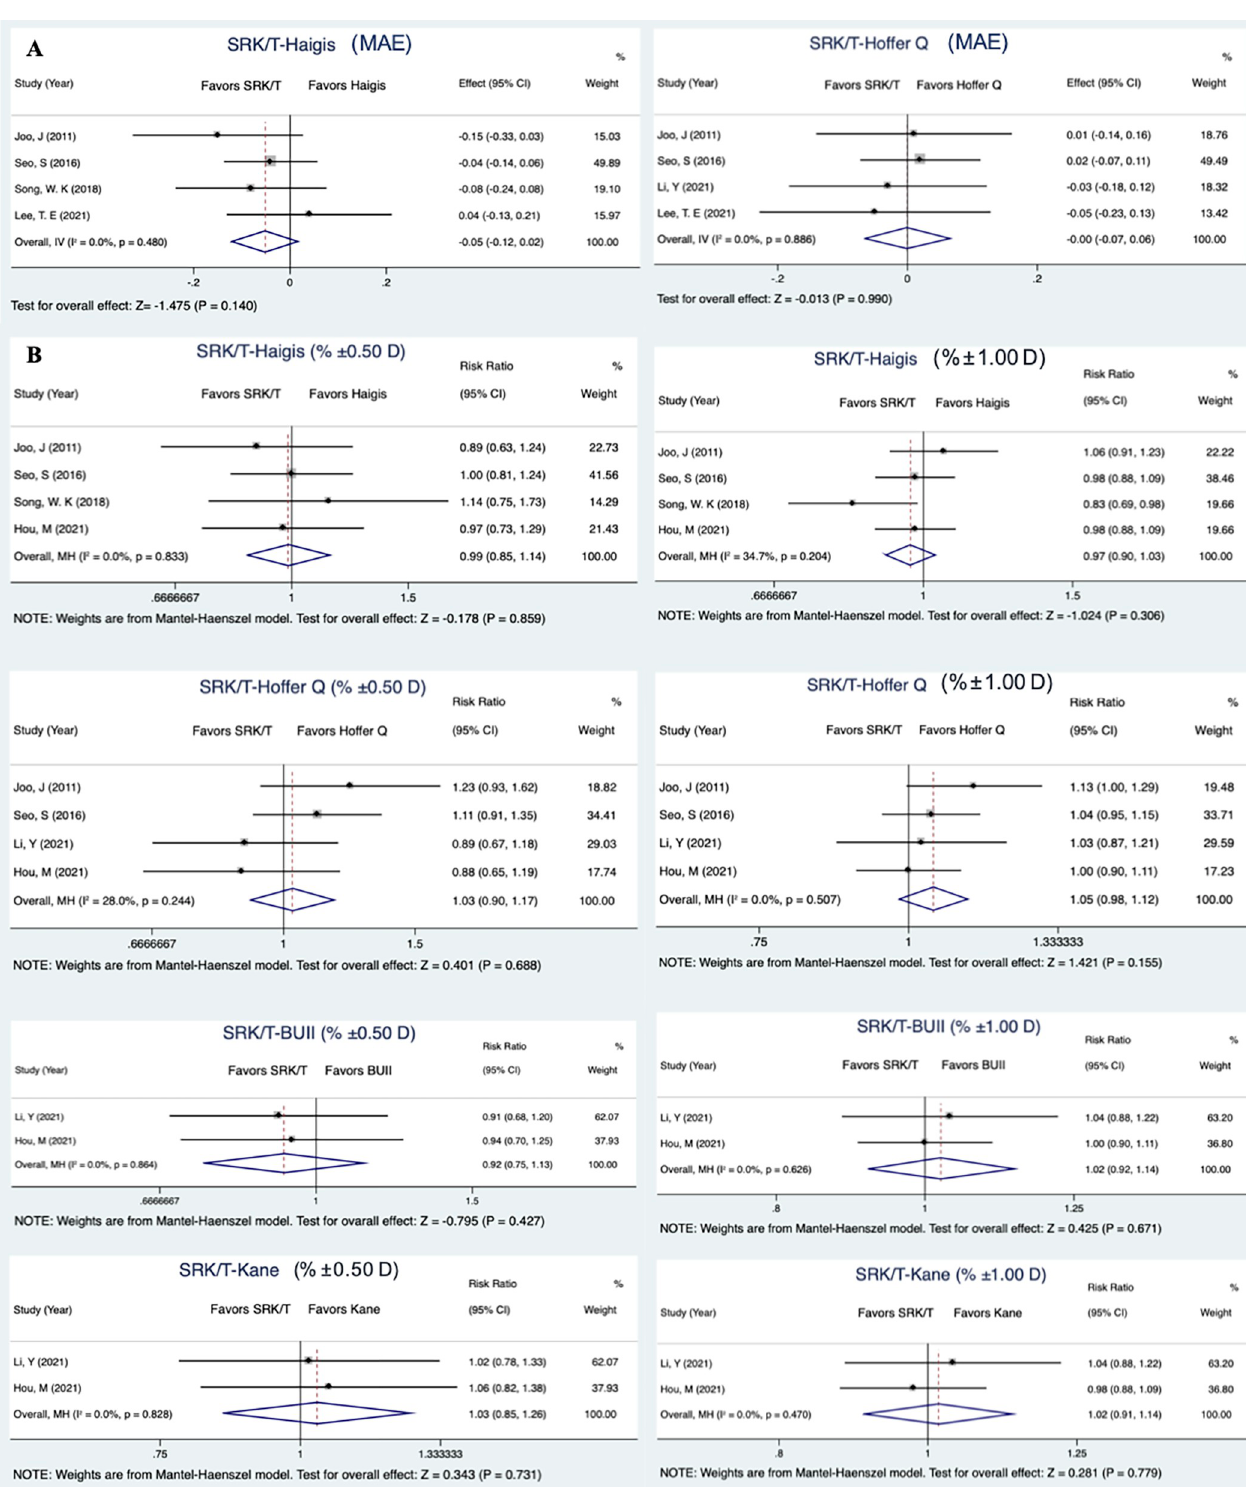
PLOS ONE | https://doi.org/10.1371/journal.pone.0276286 October 14,